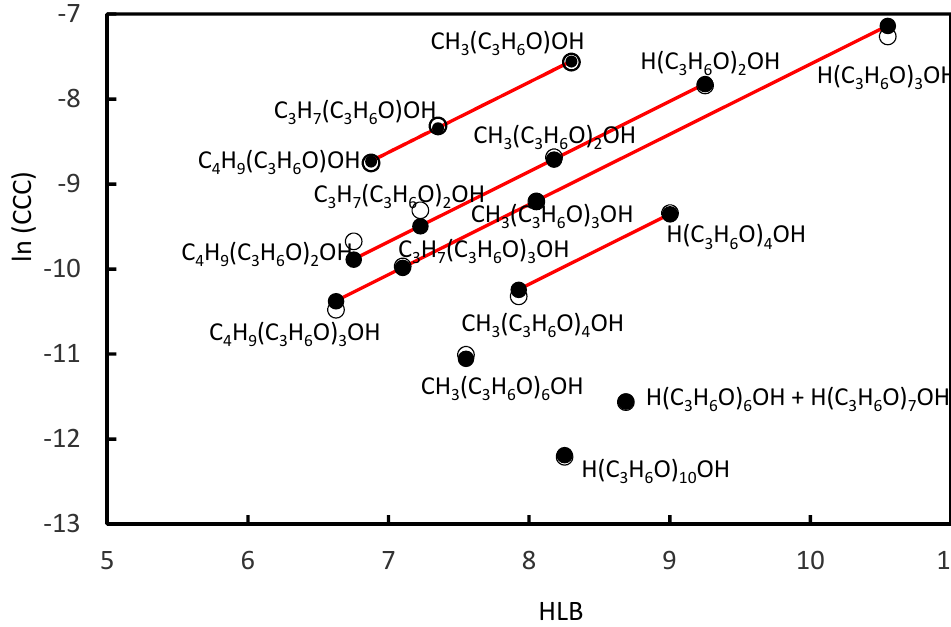
Figure 5. ln(CCC) versus HLB of Propoxy frothers of the types (C n H 2n + 1 (C 3 H 6 O)OH), (H(C 3 H 6 O) 2 OH, CH 3 (C 3 H 6 O) 6 OH, H(C 3 H 6 O) 6 OH + H(C 3 H 6 O) 7 OH, H(C 3 H 6 O) 10 OH [27,37]; empty dots represent the experimental values, while the full dots correspond the theoretical values.